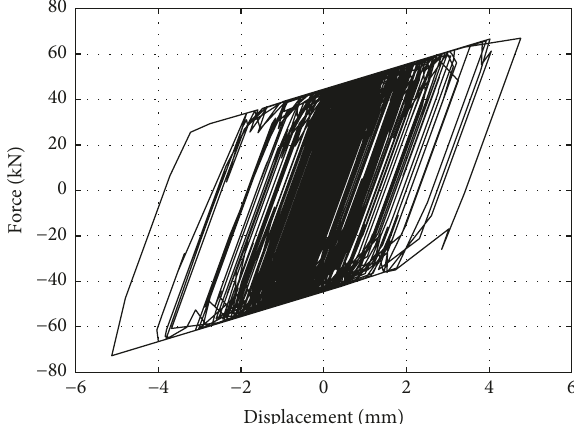
Figure 20: Roof floor displacement.